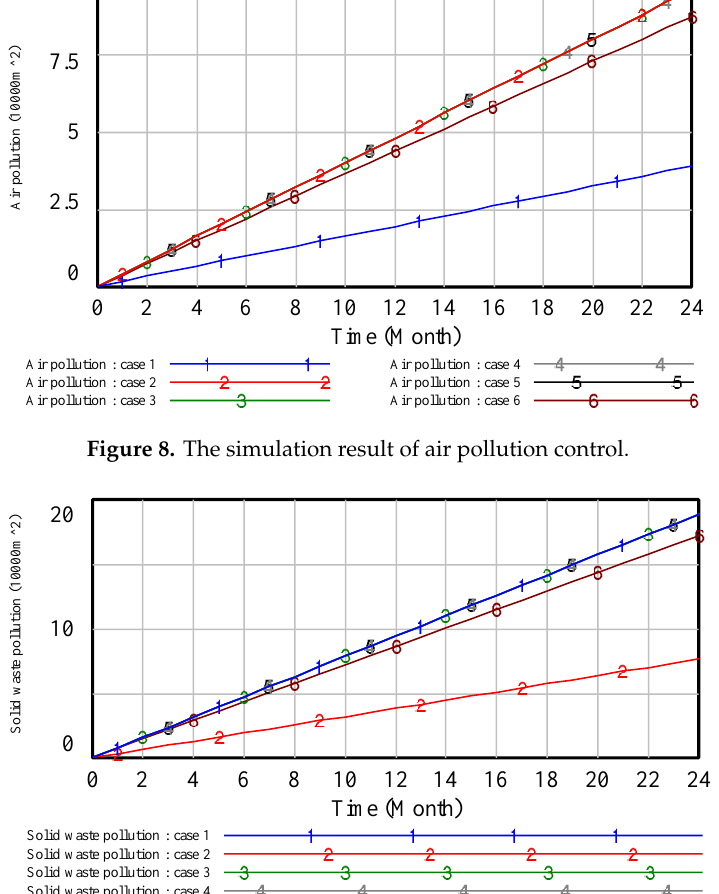
Figure 11. The simulation result of total vegetation destruction area.